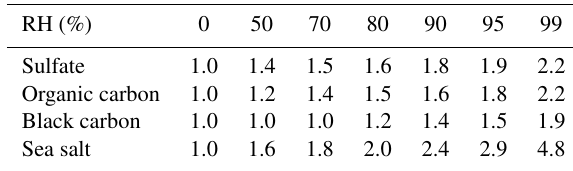
Table 2. Hygroscopic aerosol growth factor a g as a function of the ambient relative humidity